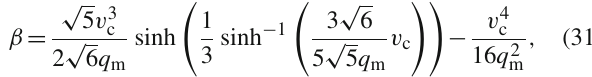
0 < β < 0 . 42 (approximately) there is one critical tem- perature (for each β ), but for 0 . 42 < β < 1 . 41, two critical temperatures. It is worth noting that Fig. 4 also shows that for each β , there are two real positive critical points v c , but for the interval 0 < β < 0 . 42, only one v c gives the physi- cal positive critical temperature. At the point v c , we have a second-order phase transition. The P − v diagrams are given